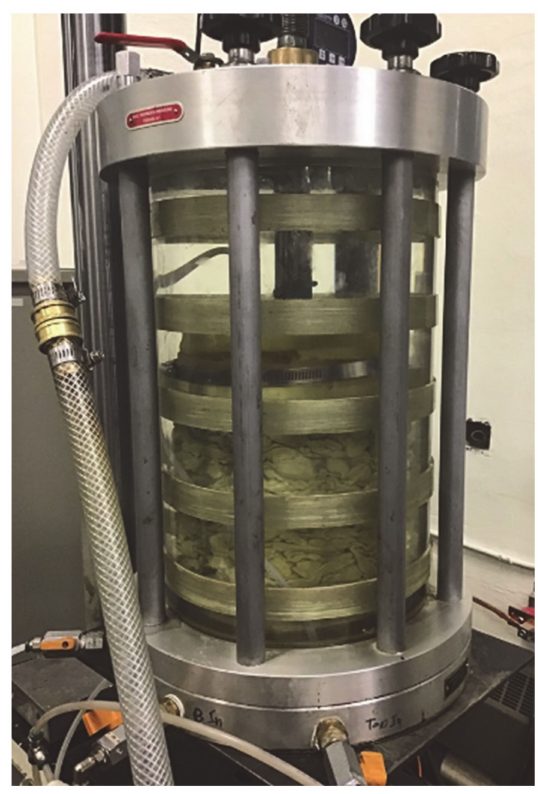
Figure 4. The sample deformation at 20%